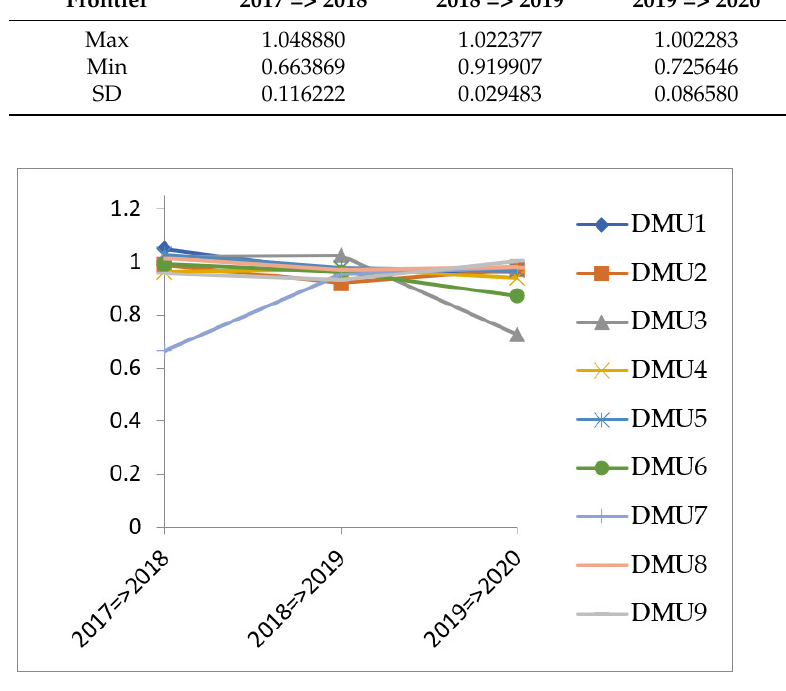
Figure 4. Technological change in DMUs (frontier-shift index). In the first period (2017–2018), except for DMU1, DMU3, DMU5, and DMU8 with scores greater than 1, the other companies did not accomplish the progress in terms of technical efficiency change. However, in the following period (2018–2019), only DMU3 maintained its advanced status. Even though DMU4 and DMU7 had improved, resulting in higher scores than in the previous span, their scores are still lower than 1. The remaining DMUs during the second period did not achieve progressive indexes, and their FS values declined. Compared with the first period, in the last period, DMU7 and 9 are two firms that demonstrated their attempts in technology innovation by obtaining better